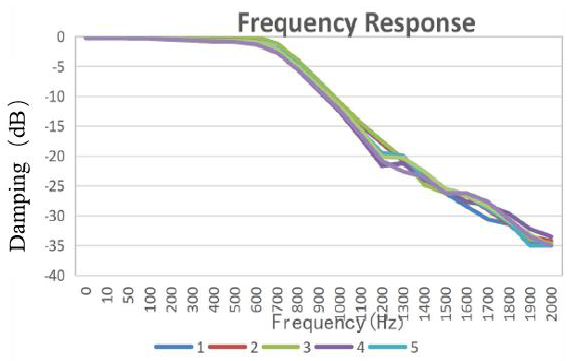
Figure 19. The diagram of frequency response.